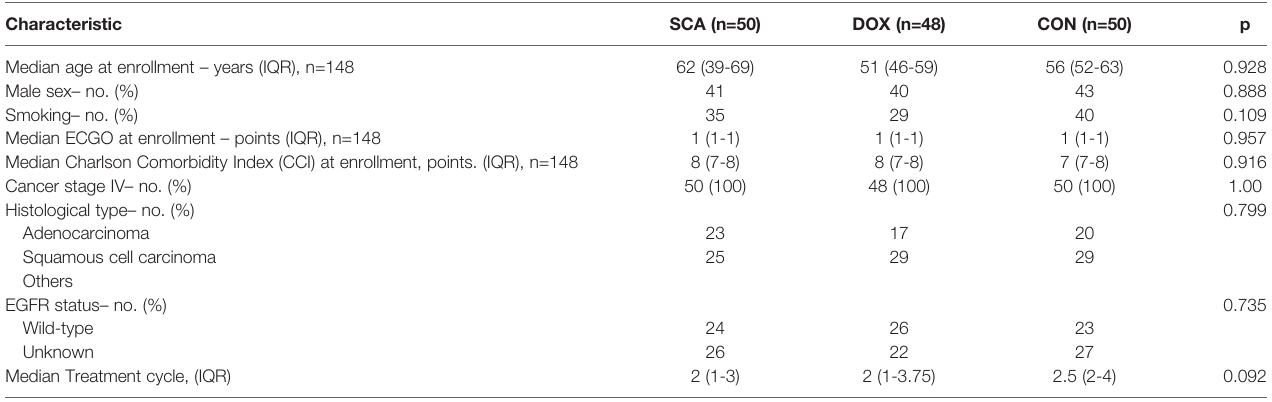
TABLE 1 | Patients ’ baseline demographic and clinical characteristics in each group (N=148).